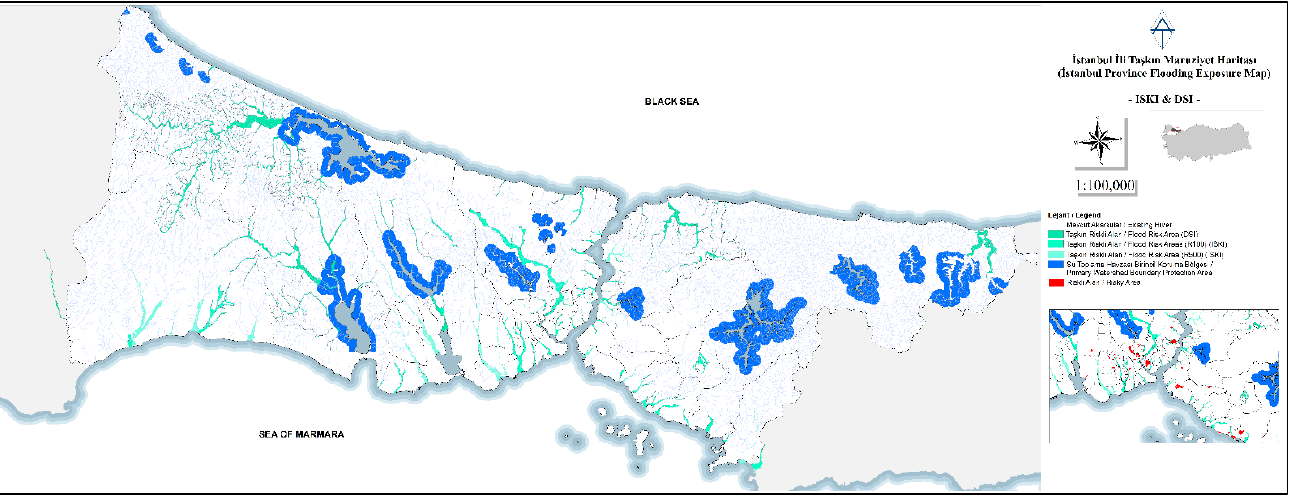
Figure 12. Istanbul Province Buildings under Flooding Risk Map. In the light of the data presented at this point, when the disaster-oriented criteria in the Law in terms of ground structure are evaluated, it is seen that the areas that are not suitable for on-site regeneration and that are under high disaster risk are not given priority in regeneration. Considering the building structure in these areas and the population